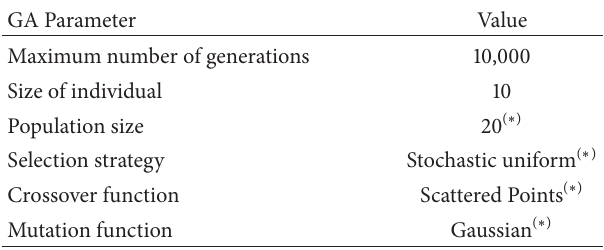
Table 6: The GA parameters used in the experiments. GA Parameter Value